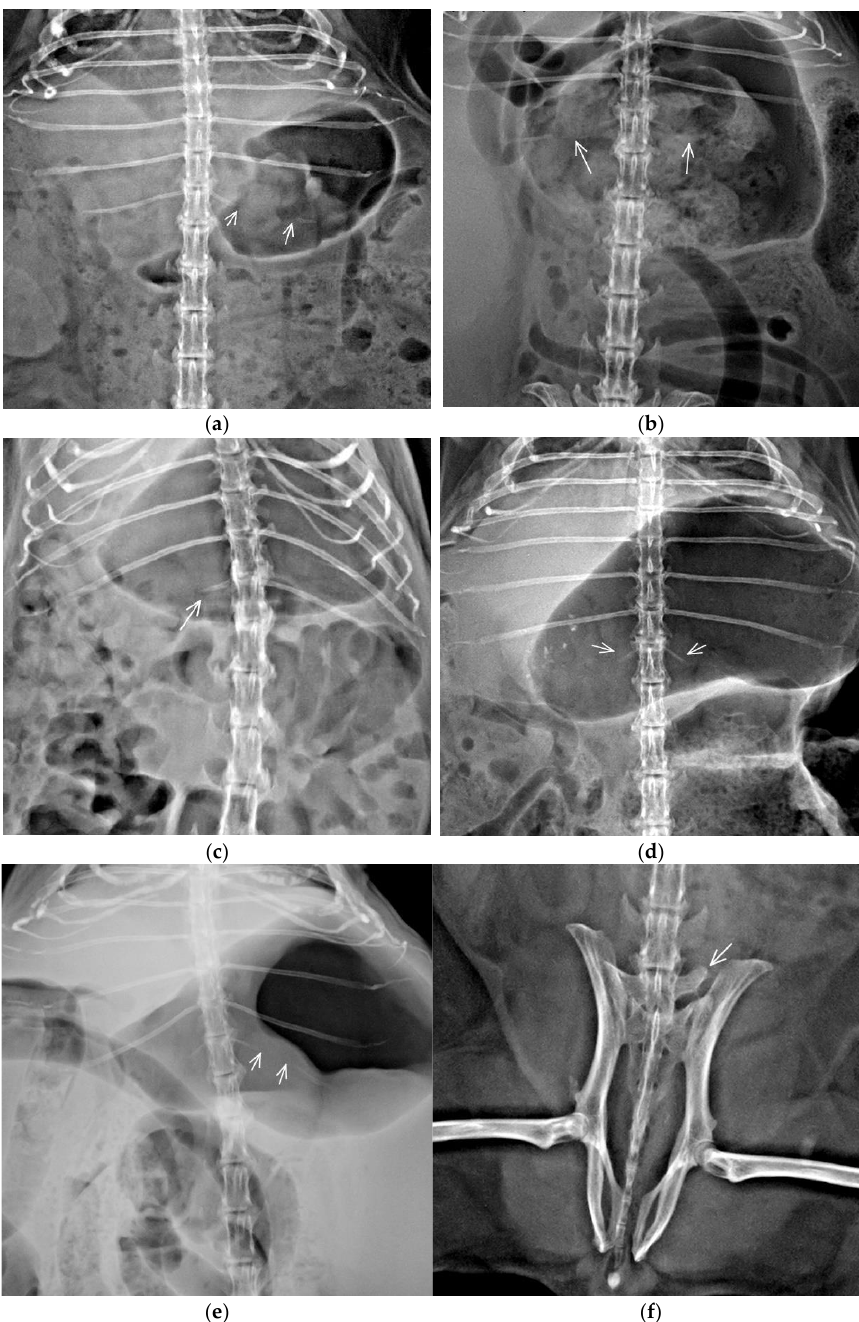
Figure 3. Ventrodorsal thoracolumbar ( a – e ) and lumbosacral ( f ) part of the vertebral column with different types of transitional vertebrae. ( a ) Thoracolumbar transitional vertebra (TTV) with unilateral segmental incomplete ossification of left rib (between arrows) ossified part of rib continues laterally; ( b ) TTV with incomplete bilateral ossification of ribs (arrows) the ossified part of the ribs continues laterally; ( c ) TTV with unilateral rudimentary rib (arrow); ( d ) TTV with bilateral rudimentary ribs (arrows), ribs are thin and oriented in a different angle than the last pair of fully developed ribs; ( e ) TTV with unilateral right rudimentary rib and contralateral incomplete ossification of rib (between arrows) ossified part of rib continues laterally; ( f ) Lumbosacral transitional vertebra (LTV) with asymmetric morphology, left transversal process is free, while the right one is attached to the ilium and sacral